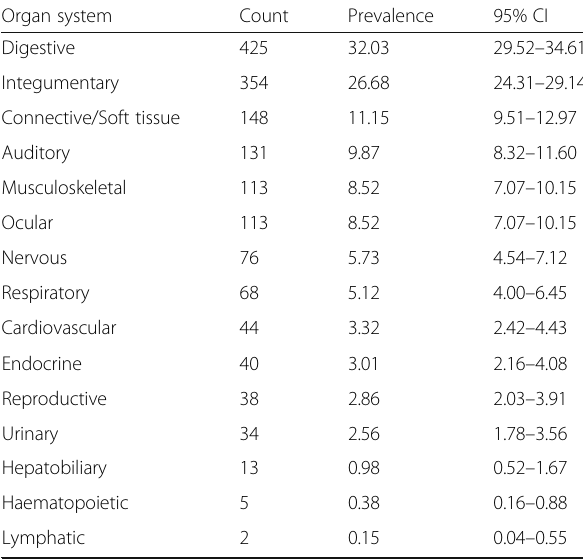
Table 5 Prevalence of organ systems affected by at least one disorder recorded in Border Terriers attending primary-care veterinary practices in England from January 1st, 2013 to